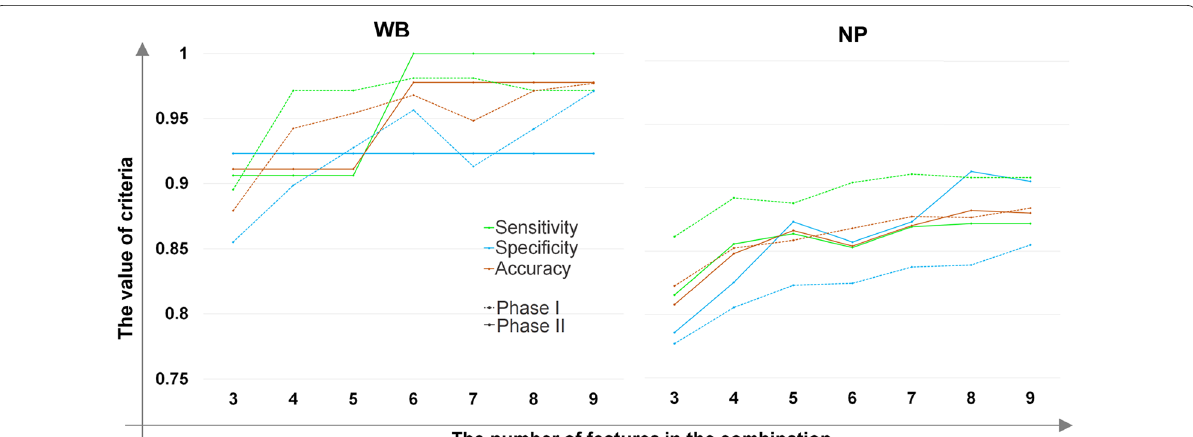
Fig. 6 The criteria of classifiers: The Line plots to indicate the value of the sensitivity, specificity, and accuracy of the classifiers for whole blood (WB) and nasopharyngeal (NP) samples in the first and second phases based on the number of